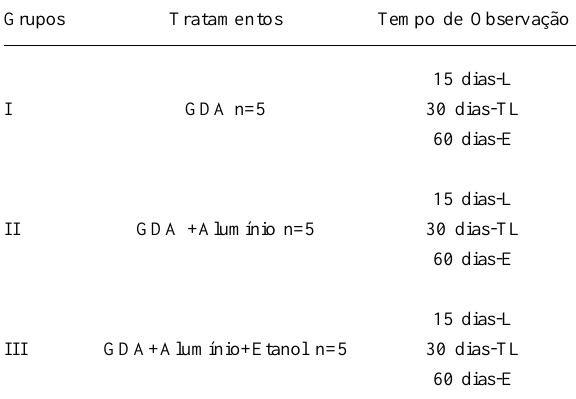
Tabela 2. Distribuição dos ratos em grupos.